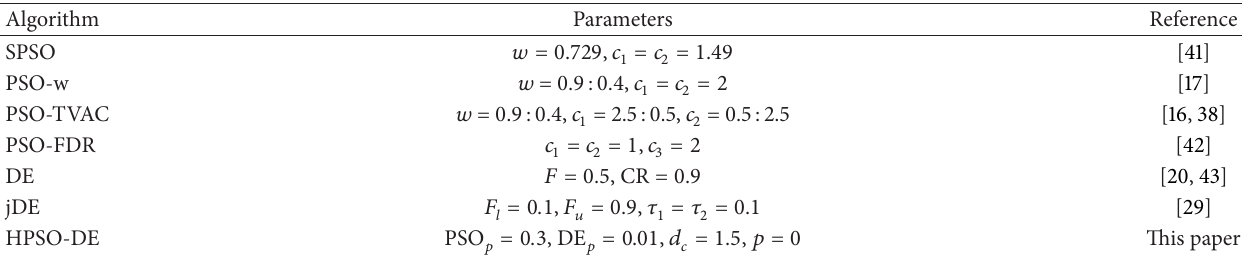
Table 2: Algorithms